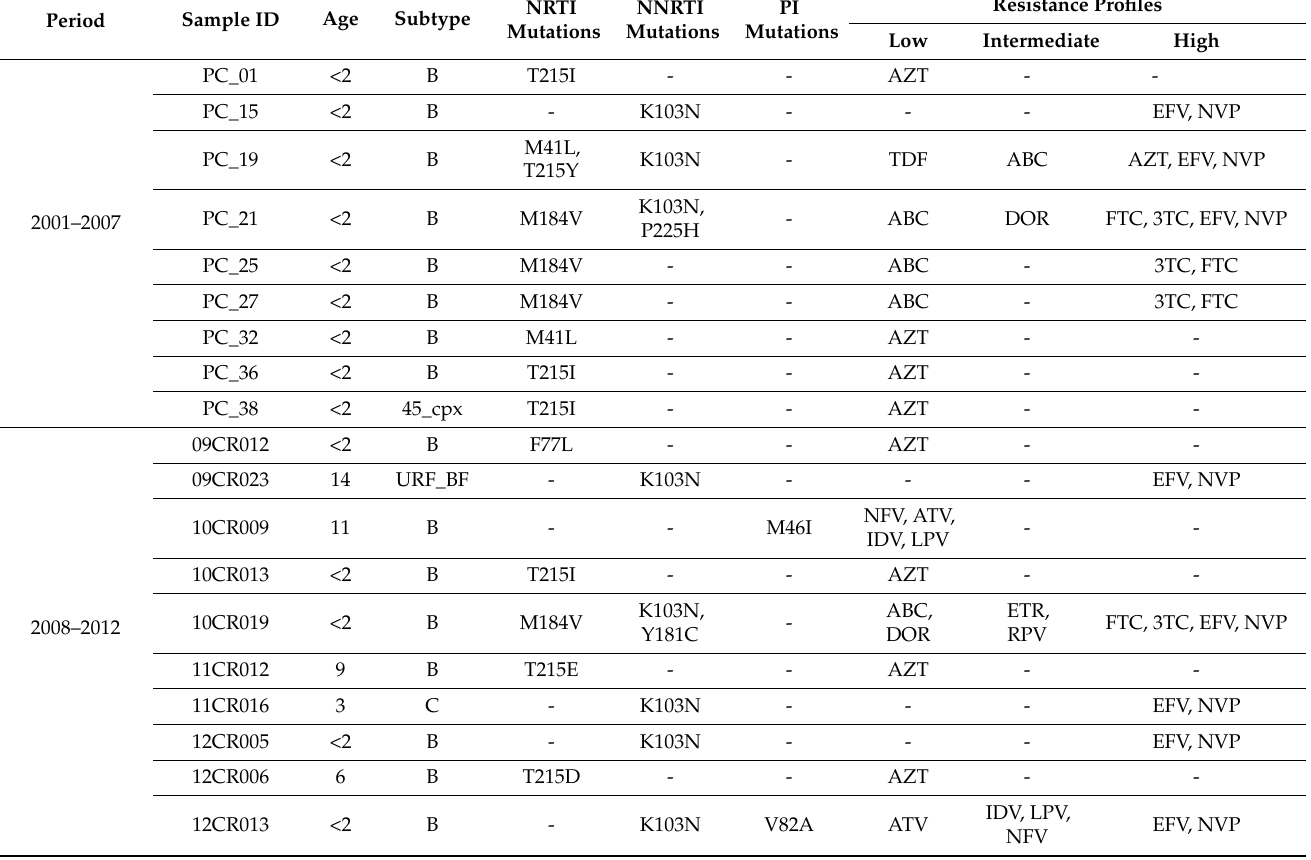
(NRTIs), non-nucleoside reverse transcriptase inhibitors (NNRTIs) and protease inhibitors (PI) transmitted drug resistance mutations, HIV-1 subtype and resistance profiles level. All TDRM observed in this period conferred resistance exclusively to reverse transcriptase inhibitors. Mutations conferring resistance to NRTIs were present in 21% (8/38) of the strains, with higher prevalence of the T215I/Y (11%, 4/38) and M184V (8%, 3/38) mutations. The only NNRTI mutation was K103N, found in 8% (3/38) of the sequences. The M184V mutation confers high HIV-1 resistance to lamivudine (3TC) and emtricitabine (FTC), in addition to low resistance to abacavir (ABC), whereas the K103N mutation confer high resistance to efavirenz (EFV) and nevirapine (NVP). The mutations T215I or M41L alone confer low resistance to zidovudine (AZT) while M41L and T215Y combined confer low resistance to tenofovir (TDF), intermediate resistance to ABC and high resistance to AZT. The mutation P225H confers intermediate resistance to doravirine (DOR). Most mutations were found in the sequences classified as subtype B (89%, 8/9). Table 2. Transmitted drug resistance mutations and resistance profiles according to time of